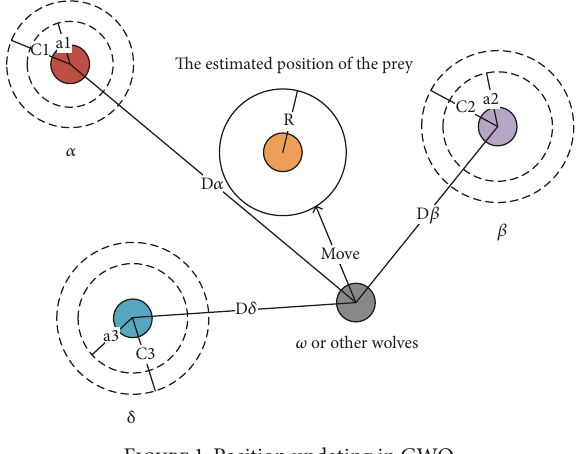
Figure 1: Position updating in